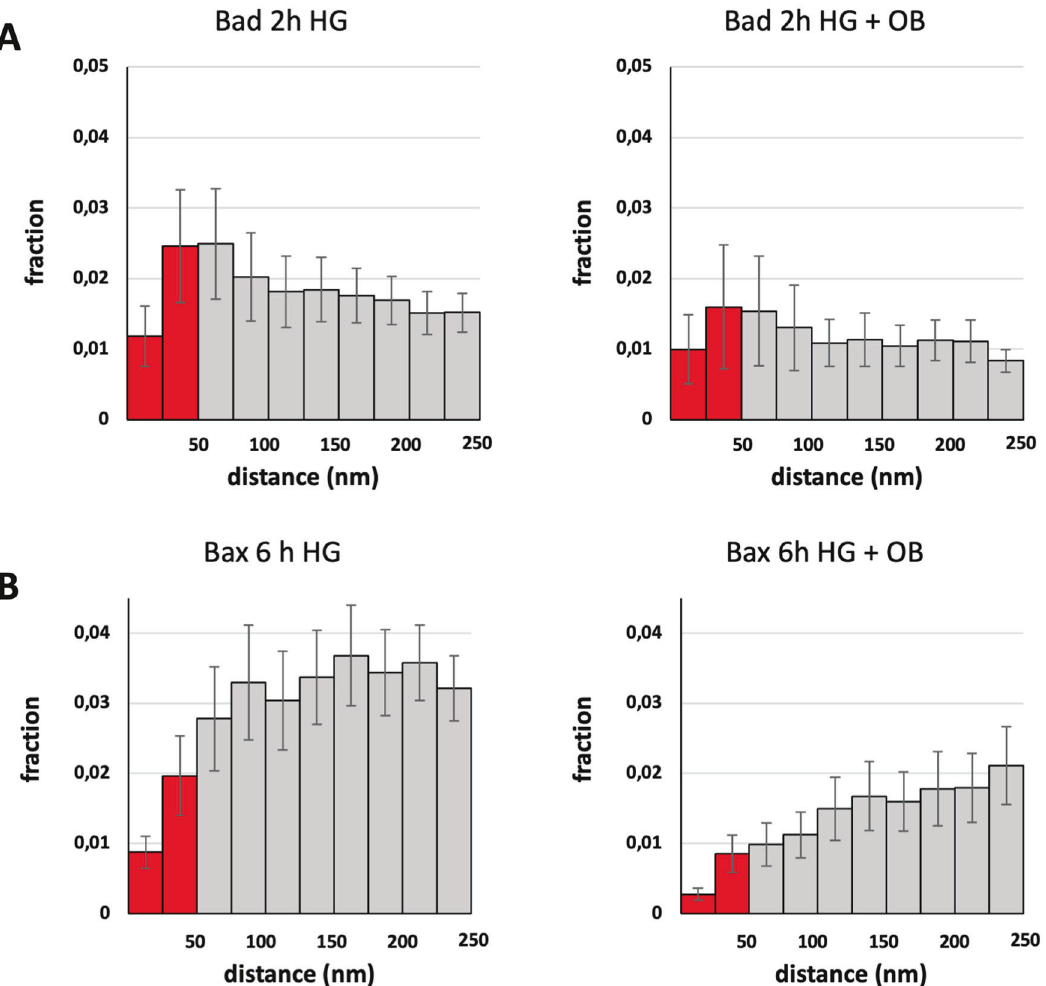
Fig. 5 Ouabain prevents glucose-induced translocation of Bad and Bax to mitochondria. A Nearest neighbor analysis of Bad and Bcl-xL in cells exposed to high glucose (HG) for 2 h with or without ouabain (OB). (For control see Fig. 3B). B Nearest neighbor analysis of Bax and Bcl-xL in cells exposed to high glucose for 6 h with or without ouabain. (For control see Fig. 2B). The analysis con fi rms that ouabain effectively prevents translocation of Bax to